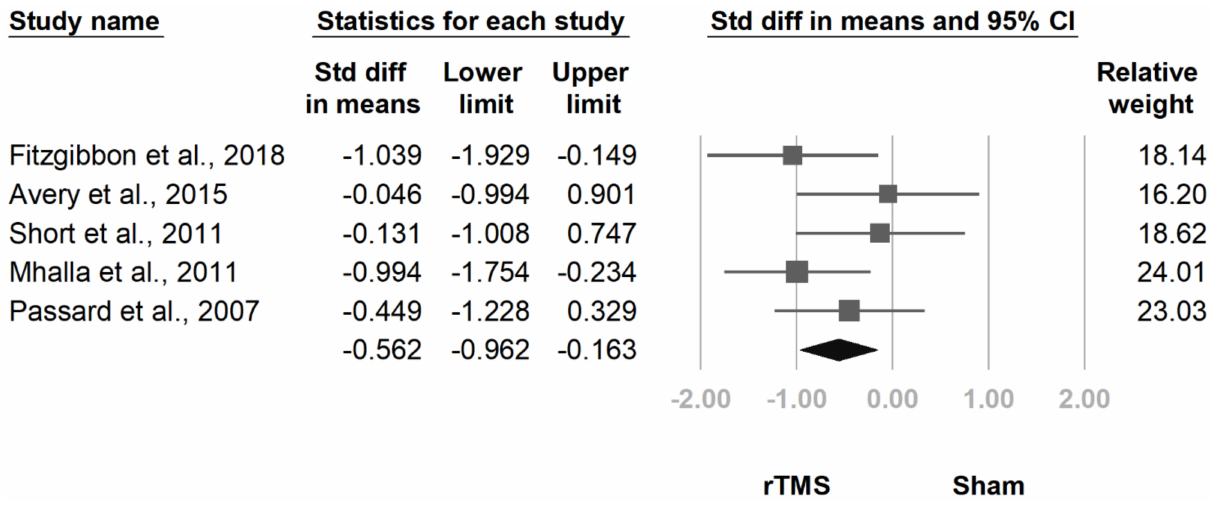
Figure 10. Forest plot of standardized mean differences in the interference subscale of the Brief Pain Inventory at follow-up at 2 weeks to 1 month after the last treatment session. Squares indicate effect sizes of individual studies, lines indicate 95% CI, and diamond indicates the summarized effect